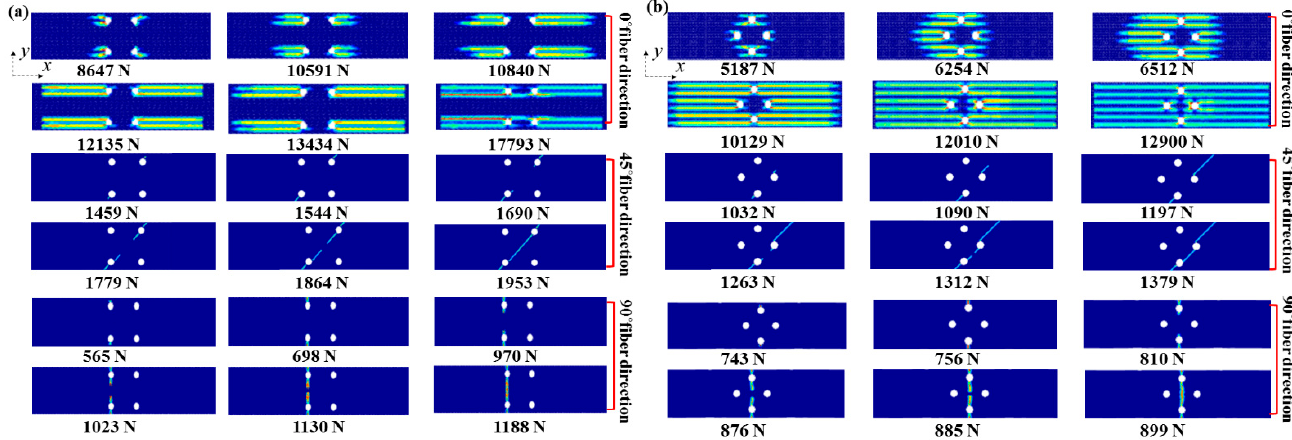
Figure 6. Observation of crack propagation in unidirectional composite plates for three different fiber directions with ( a ) four square holes ( b ) four diamond holes.